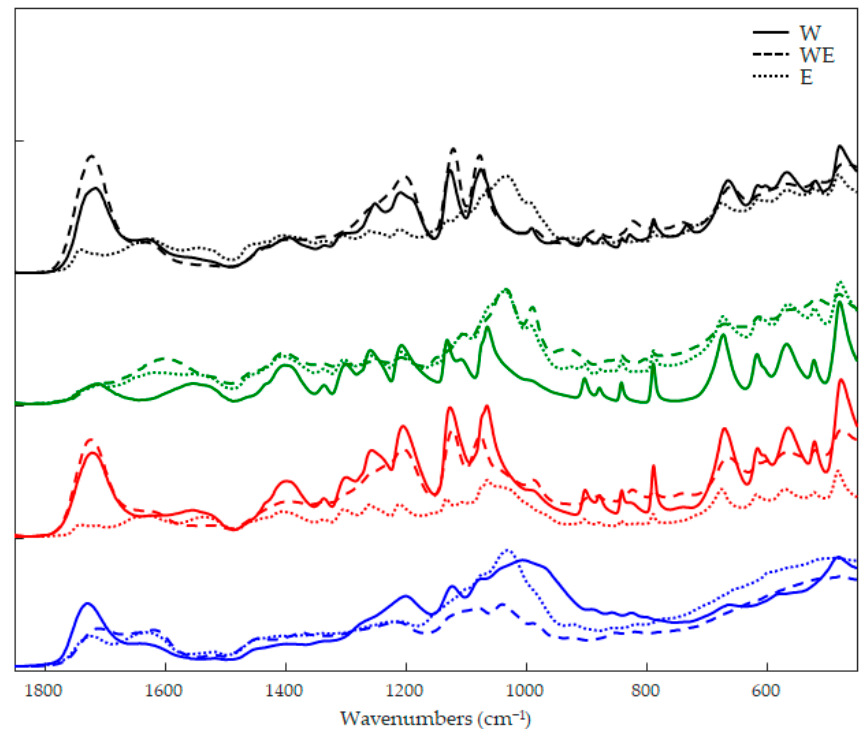
Figure 2. FTIR spectra for the different wine lees extractions: Nocera Rosso L1 (blue line), Magliocco Rosato L2 (red line), Magliocco Canino L3 (green line), and Gaglioppo L4 (black line), extracted by water (W, solid line), ethanol (E, dotted line), and hydroalcoholic (WE, dashed line) solutions.